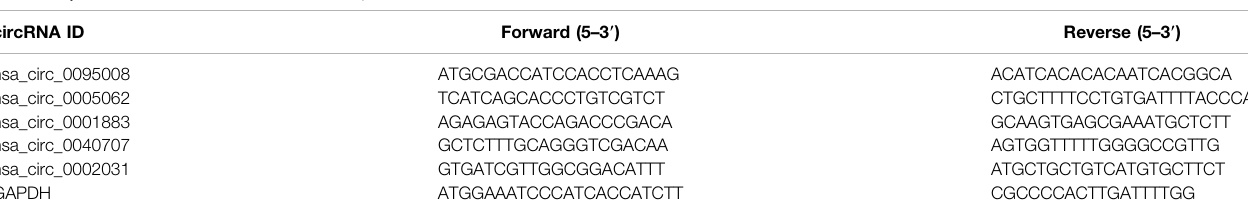
TABLE 1 | Primers of validated circRNAs in